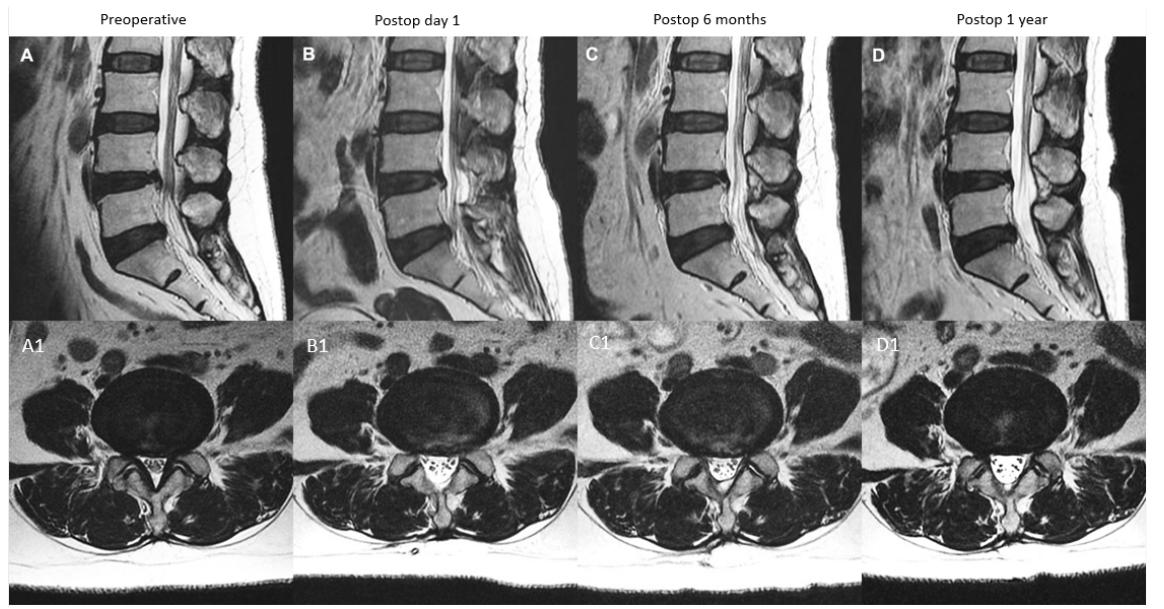
Figure 4. MRI appearance of remodeling patterns at preoperative, postoperative day 1, postoperative 6 months and postoperative 1 year with mid-sagittal cut in the top row and corresponding axial cut in the bottom row. Type A: continuous type, preoperative spinal stenosis at L4/5 ( A , A1 ) with increased spinal canal area on postoperative day one MRI ( B , B1 ). There was modest restenosis that occurred at postoperative 6 months ( C , C1 ), which was maintained at postoperative one year with overall improved spinal canal area ( D , D1 ).